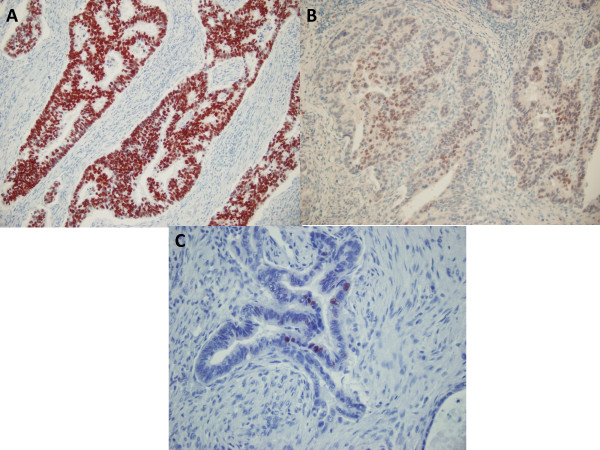
CDX2 expression patterns in colorectal, gastric, and pancreatic carcinomas. (A) Homogeneous (diffuse and strong) nuclear expression of CDX2 in a low grade colorectal adenocarcinoma. (B) Gastric and (C) pancreatic adenocarcinomas showed heterogeneous pattern of intensity of CDX2 expression, frequently encountered in extra-intestinal GI adenocarcinomas. (A)-(B), original magnification × 200; (C), original magnification × 400.